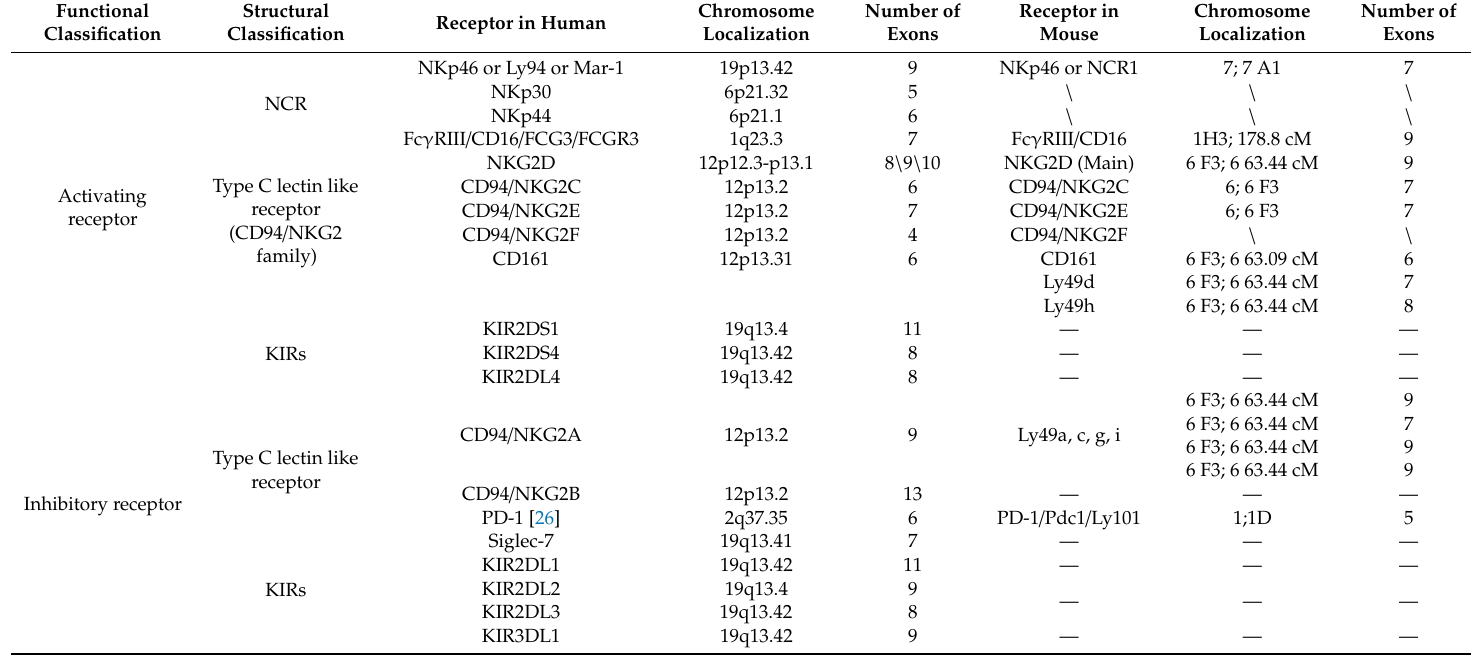
Table 1. The characteristics of activated and inhibitory receptors of NK